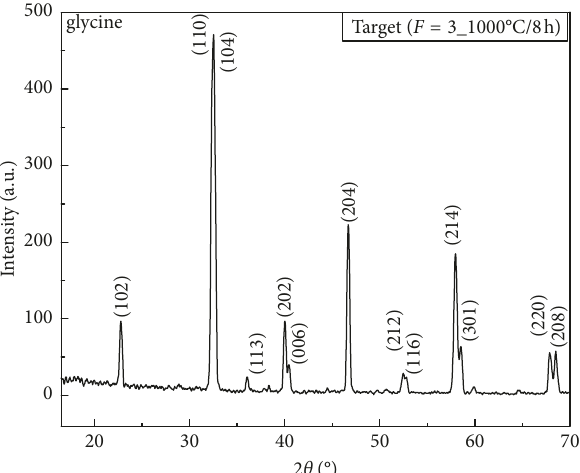
Figure 4: XRD pattern of the LaMnO nanoparticles prepared by self-combustion assisted with micro- wave irradiation.